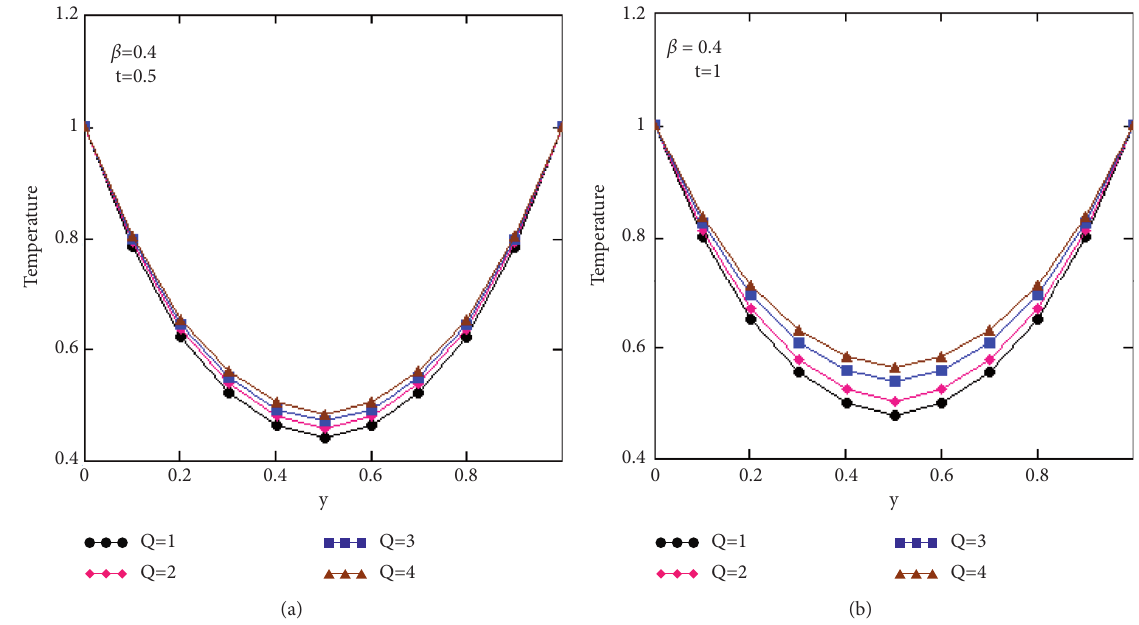
Figure 4: Profiles of dimensionless temperature versus y for variation of Q at altered values of time t , Pr � 20, and f